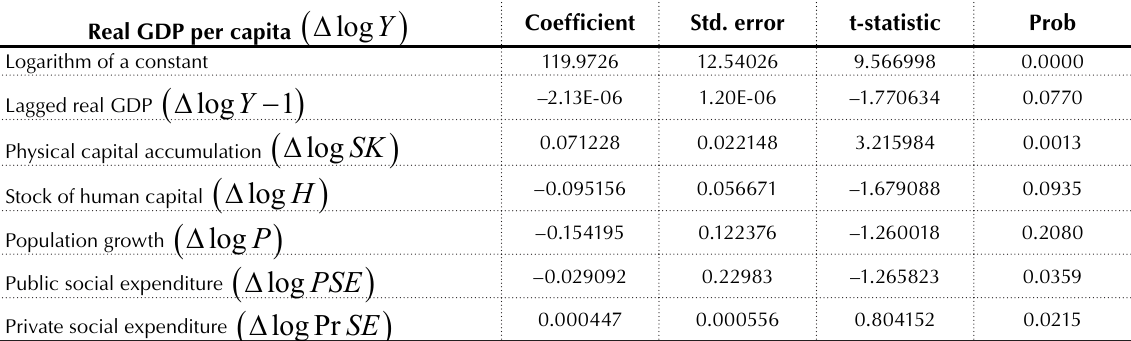
Table 4. Pooled Regression for the logarithm of real GDP per capita and the logarithm of socio- economic factors